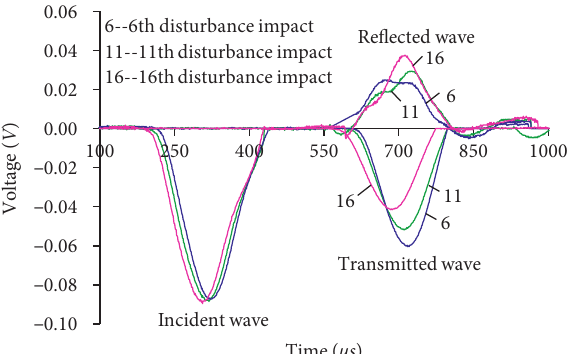
Figure 3: The typical voltage-time curves of rock sample during unloading under high static stress and frequent